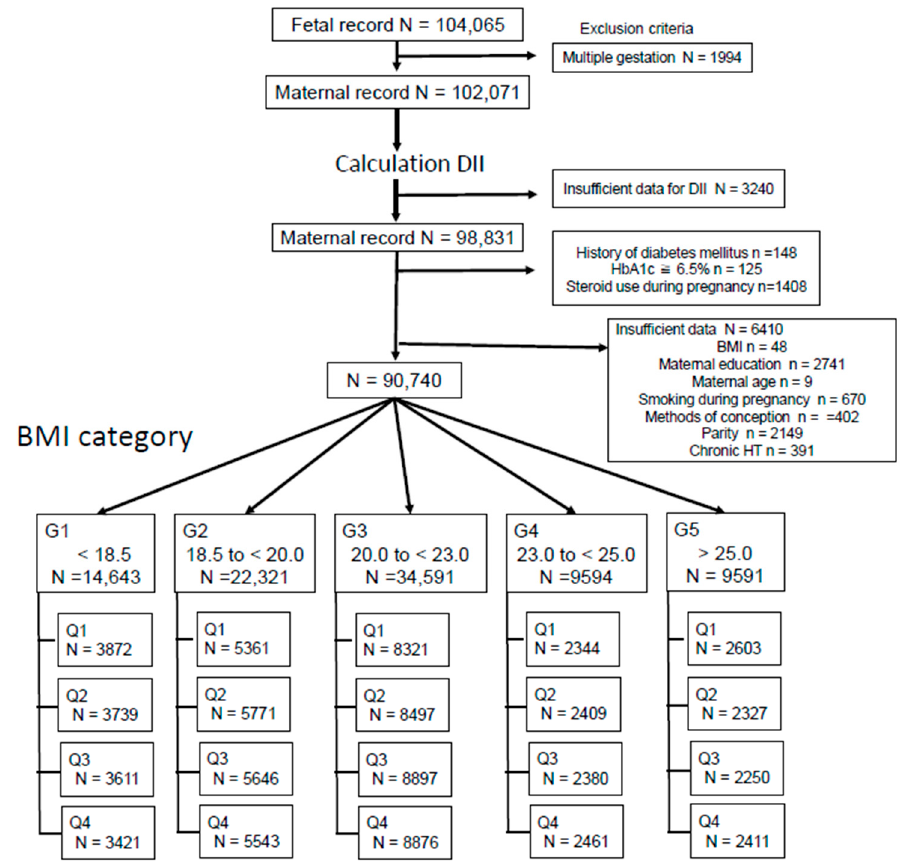
Figure 1. Study Figure 1. Study flow.